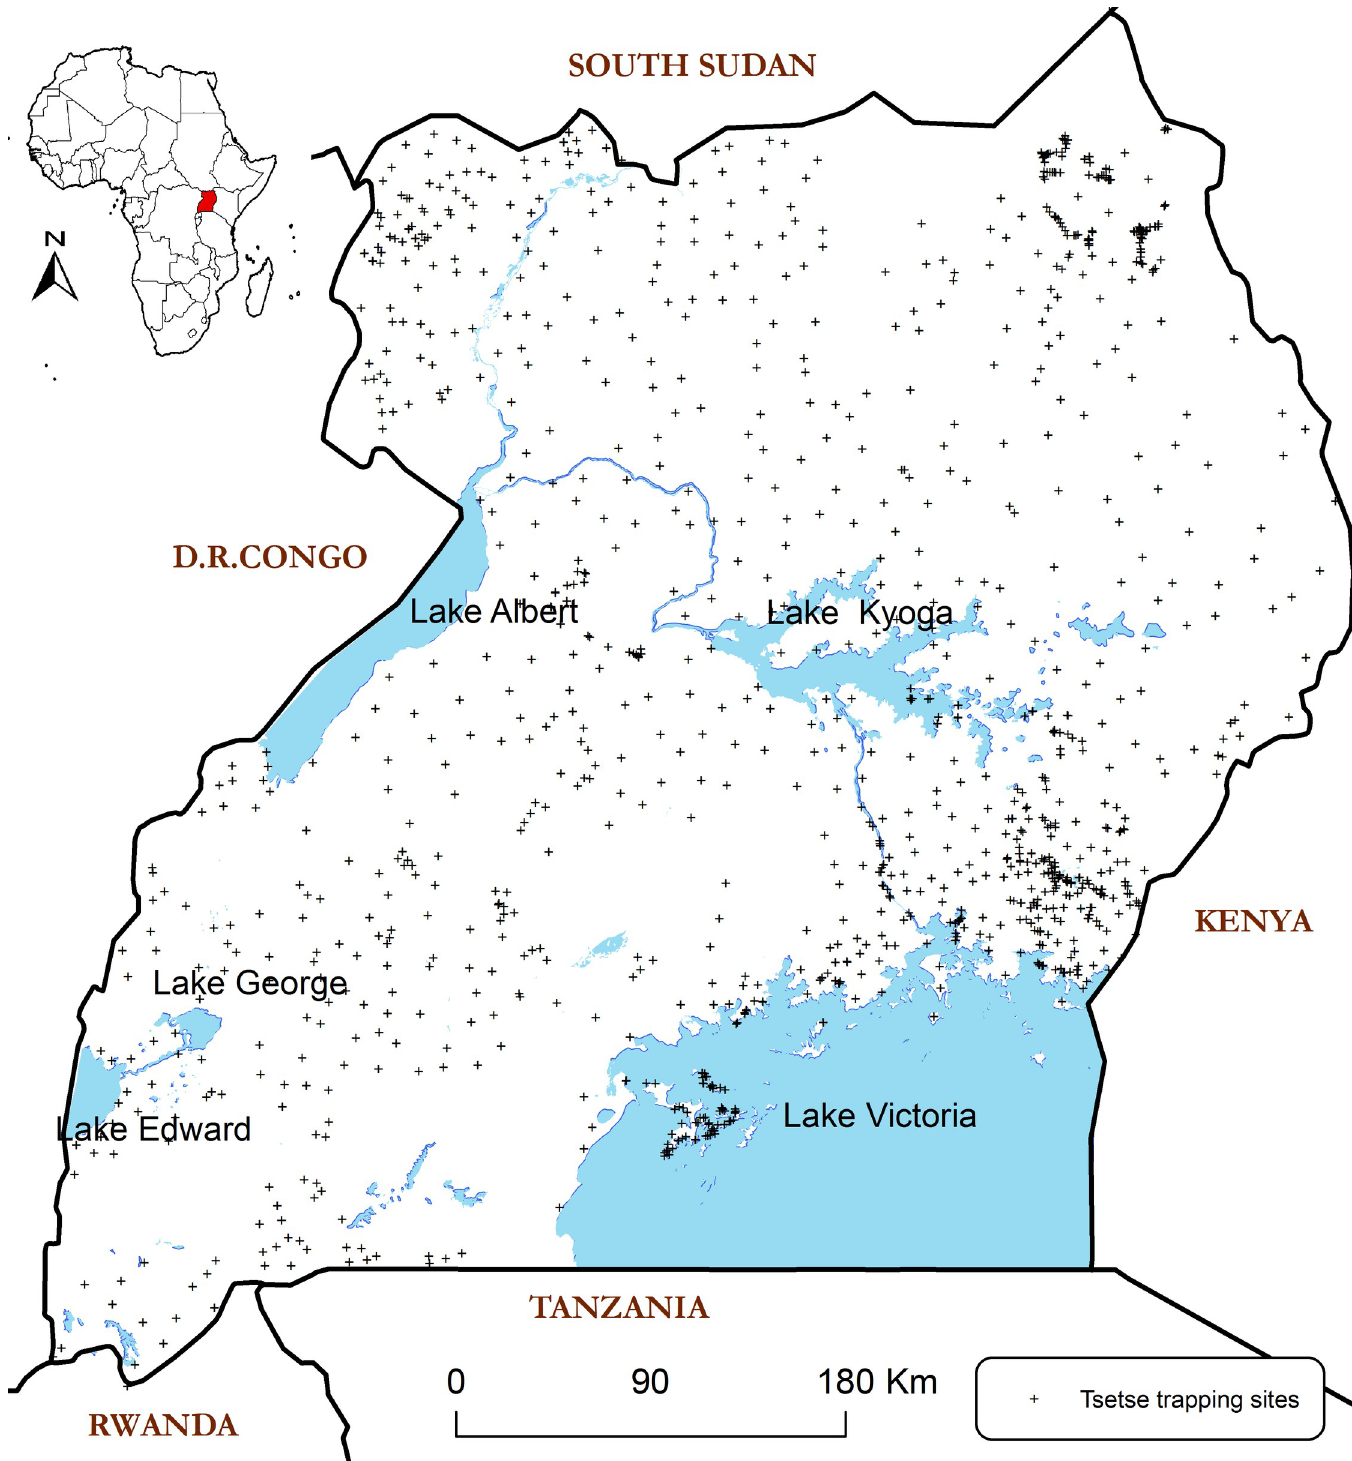
Fig 1. Location of areas (points) with tsetse data in Uganda as applied in the model. Base map showing country boundaries of Uganda constructed using GIS shapefiles was obtained from the public domain https://data2.unhcr.org/en/documents/details/83043. This map has been processed and visualization enabled using ArcGIS 9.1 as the GIS